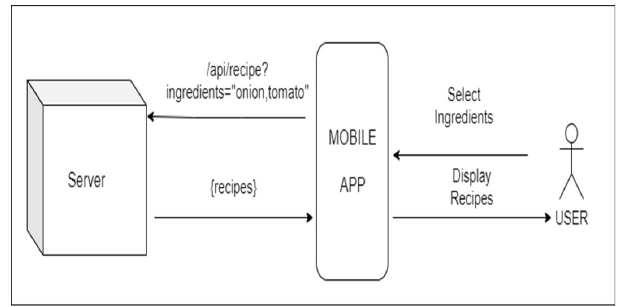
Fig. 1. Block Diagram of